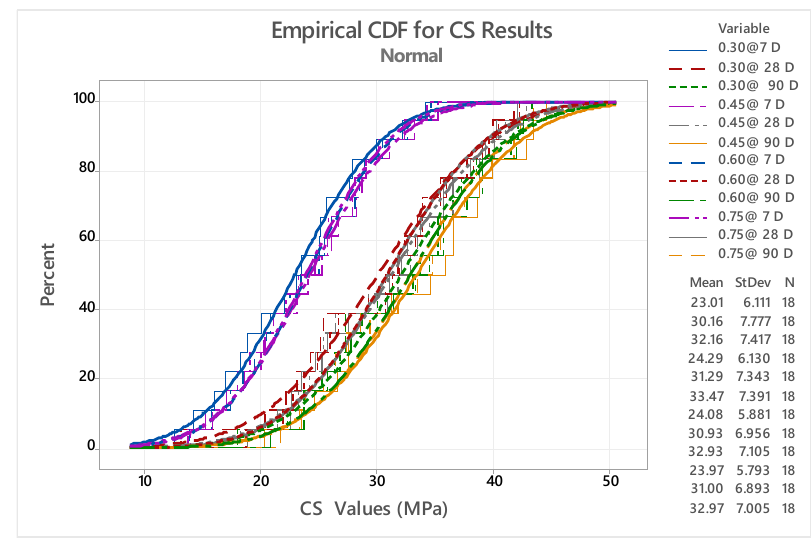
Figure 7. Commutative distribution factor (CDF) curve for CS results.